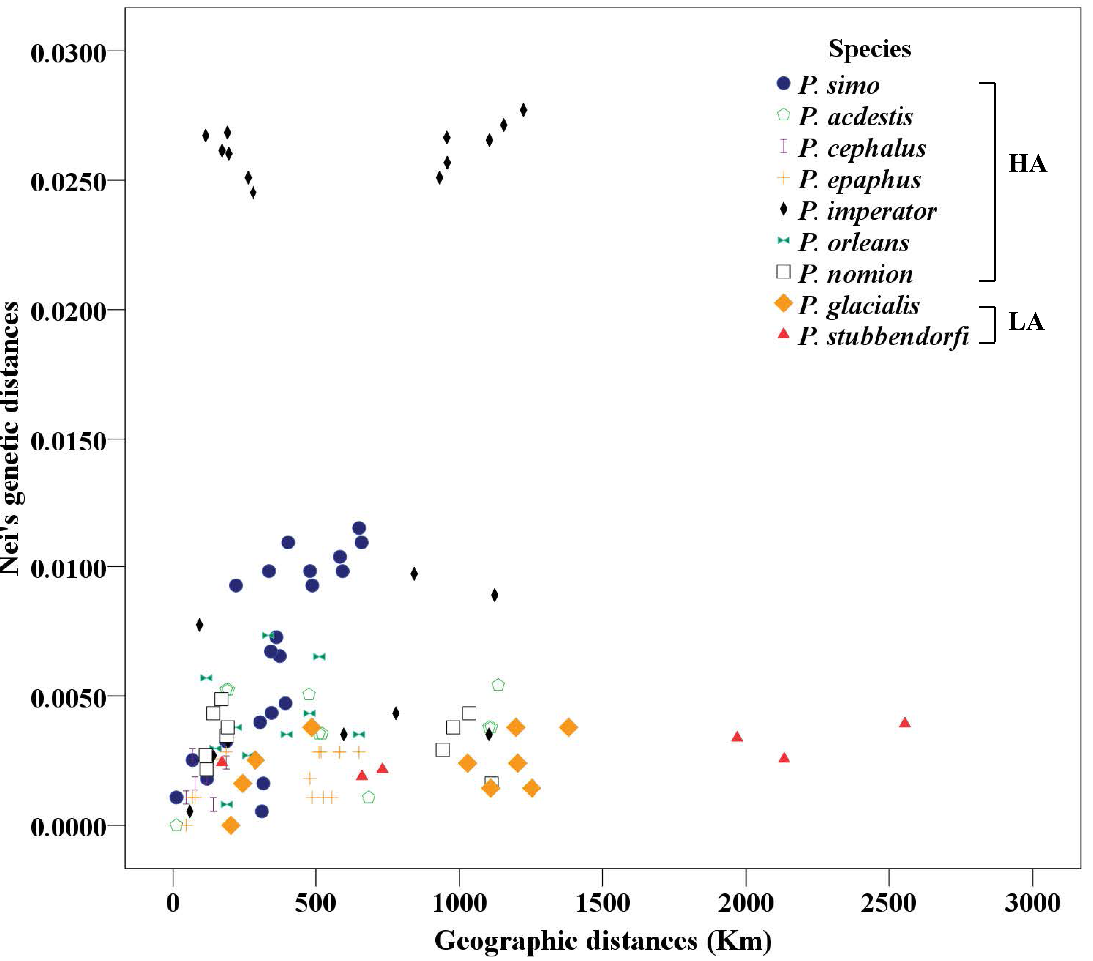
Figure 2. Genetic distance versus geographic distance among the populations of Parnassius species in this study. HA: high-altitude; LA: low-altitude. The altitude distributions of the Parnassius species in this study are presented in Table 2.